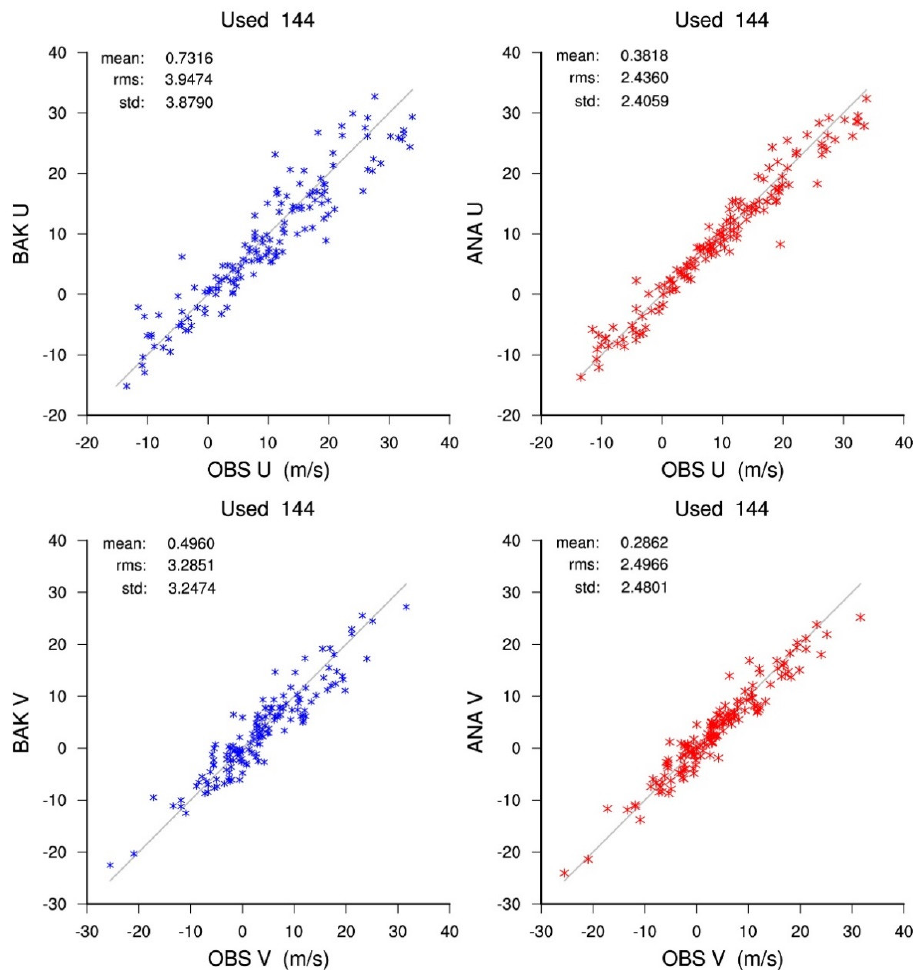
Figure 5. Scatter plots of the background and analysis of U and V wind against the corresponding components of FY-4A AMVs with a QI > 80 for the level of 300 hPa at 00 UTC 20 July 2021 (the first line represents U wind, and the second line represents V wind).